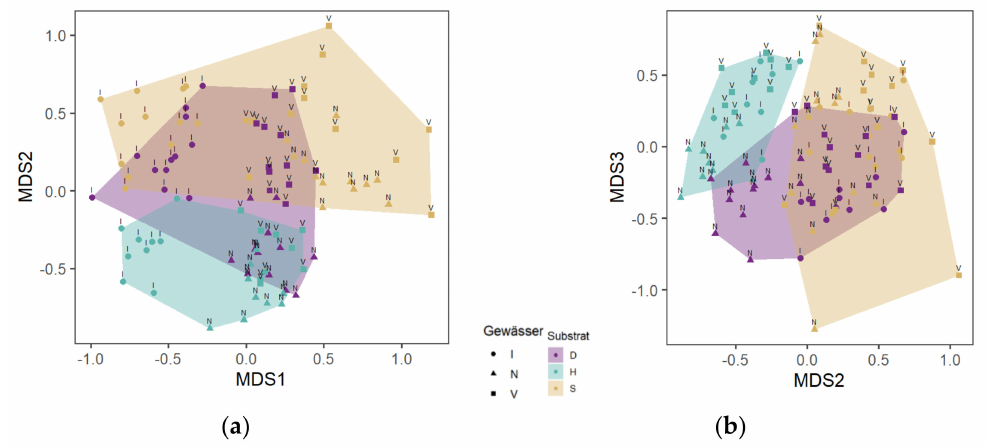
Figure 4. Non-metric multidimensional scaling (NMDS) of MI samples from the WS ( a ) and the CS ( b ) of streams I—Ihle, N—Nieplitz and V—Verlorenwasser and the substrates D—detritus, H—wood and S—sand. Stress—0.17 ( © Katja